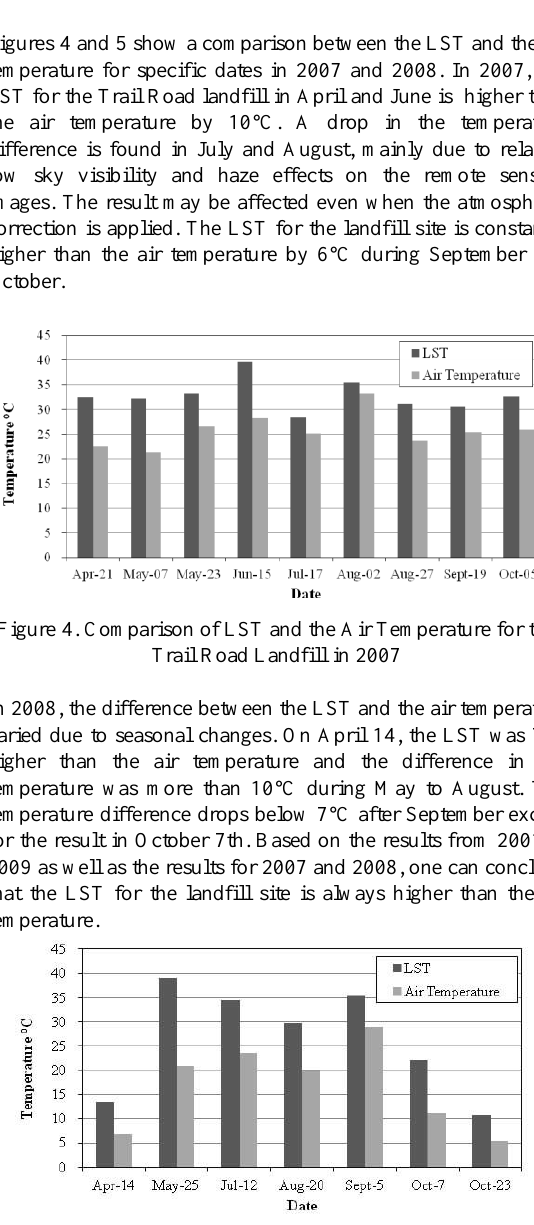
Figure 3. Experimental Workflow